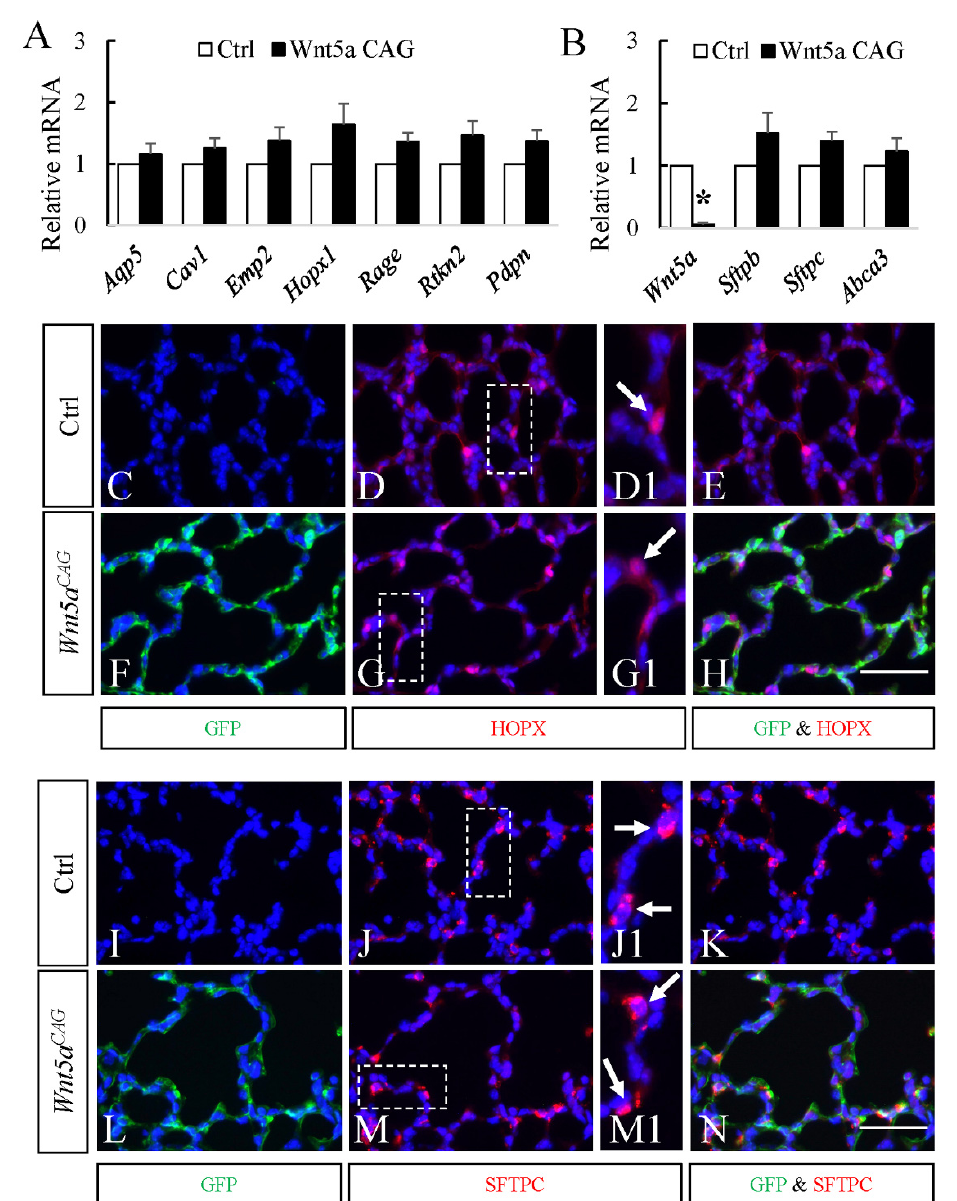
Figure 4. No significant changes in AT1 and AT2 cell markers in P12 Wnt5a CAG lungs. A – B: Relative mRNA for AT1( A ) and AT2 ( B ) cell markers in Wnt5a CAG lungs (Wnt5a CAG, P12-13) compared to littermate control lungs by real-time RT-PCR analysis. C – H: Immunostaining of GFP (green) and HOPX (red) in P12 control ( C , D , D1 and E ) and Wnt5a CAG ( F , G , G1 and H ) lungs. D1 and G1 show higher magnification views of boxed areas in D and G, respectively. Arrows indicate HOPX-positive cells. Scale bar ( H ): 50 µ m for C , D , E , F , G and H ; 25 µ m for D1 and G1 . I – N: Immunostaining of GFP (green) and SFTPC (red) in P12 control ( I , J , J1 and K ) and Wnt5a CAG ( L , M , M1 and N ) lungs. J1 and M1 show higher magnification views of boxed areas (rotated 90 degree clockwise in M1 ) in J and M , respectively. Arrows indicate SFTPC-positive cells. Scale bar ( N ): 50 µ m for I , J , K , L , M and N ; 25 µ m for J1 and M1 . Data represent the mean ± SEM. * indicates p < 0.05. n = 4.